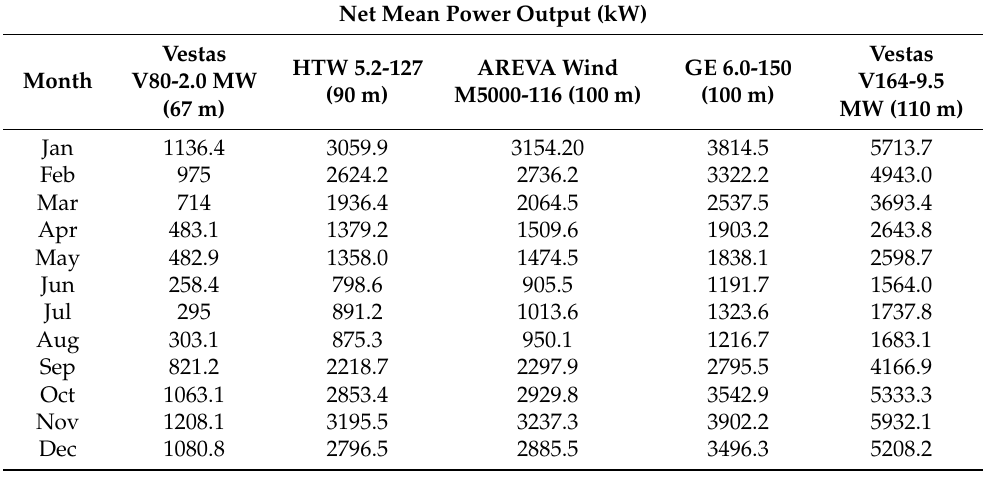
Table 2. 2019 Monthly net mean power output for five wind turbines.